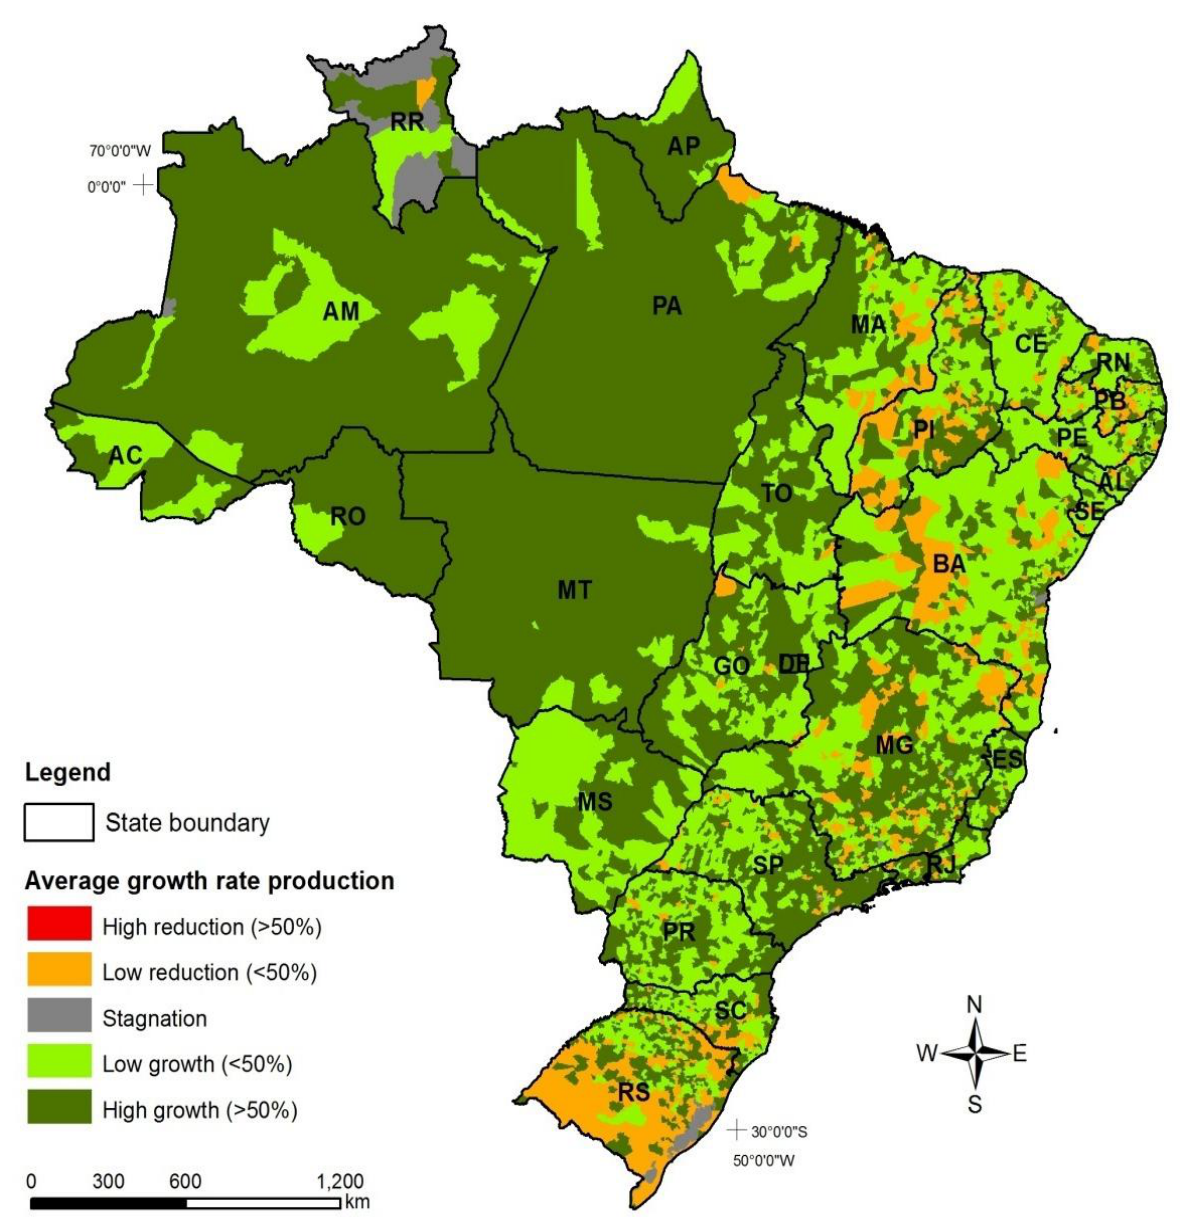
Figure 2. Average growth rate of sheep production in Brazil between 1976 and